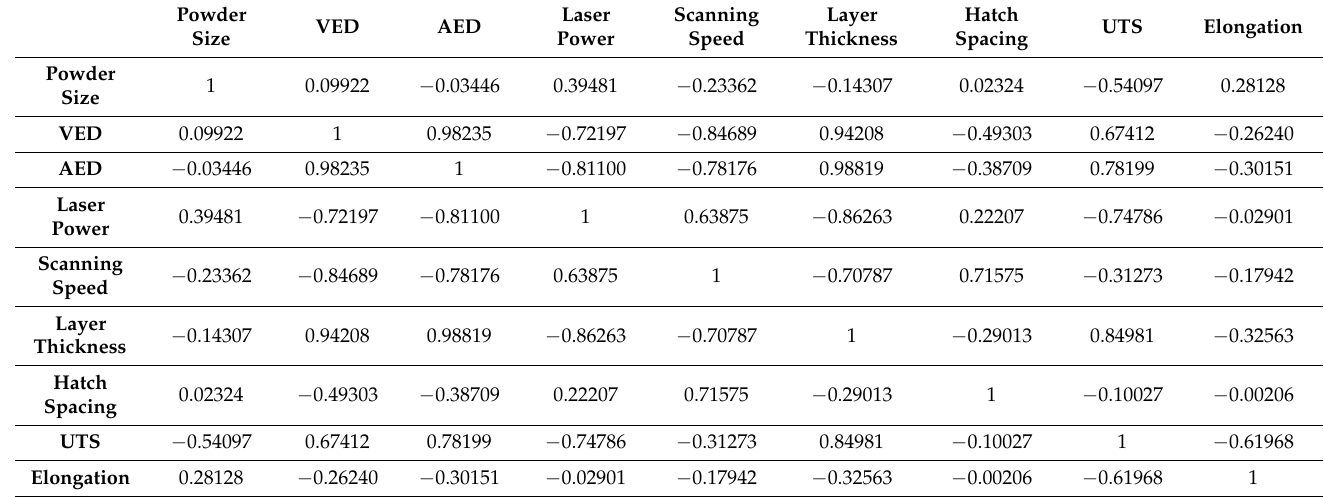
Table 1. Correlation matrix of PCA for L-PBF of polymer powder